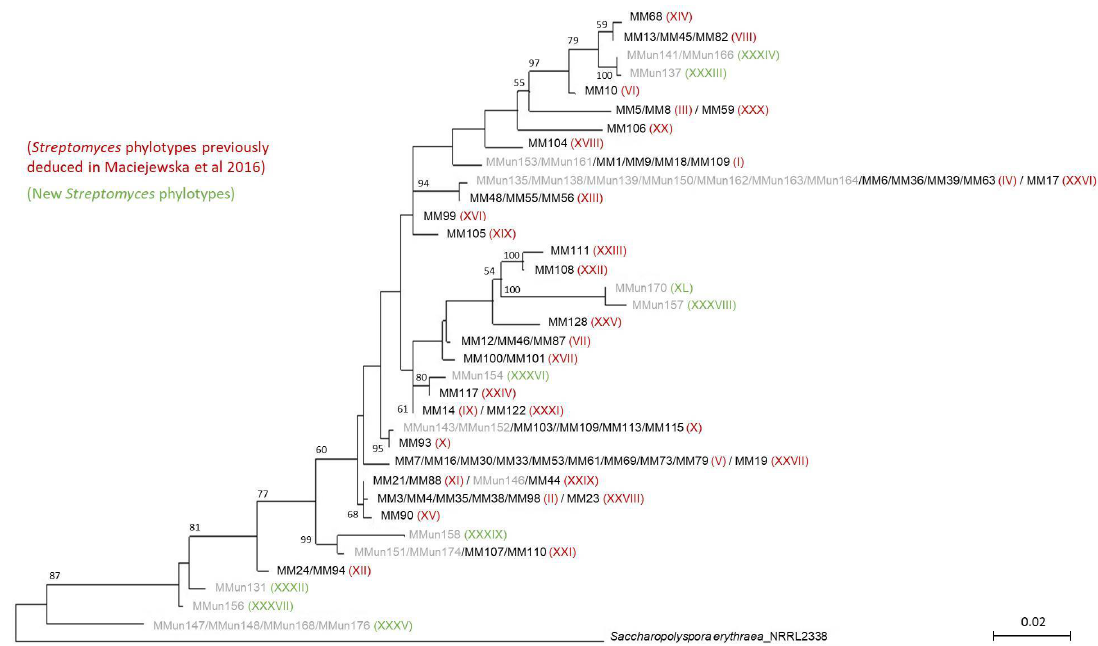
Figure 4. 16S rRNA-based phylogenetic tree of moonmilk-dwelling Streptomyces strains. Strains isolated using the rehydration-centrifugation (RC) method (MMun) are shown in grey, and strains isolated in our previous study (MM) are in black. Phylotype affiliations are indicated in parentheses. The alignment of nearly complete 16S rRNA sequences had 1538 unambiguously aligned positions for 92 strains, but only the 1342 positions without missing nucleotides were used to infer the tree. The evolutionary model was GTR + Γ 4 and bootstrap values are based on 100 pseudoreplicates (bootstrap values <50% are not displayed). Saccharopolyspora erythraea was used as outgroup. The scale bar represents 0.02 substitutions per